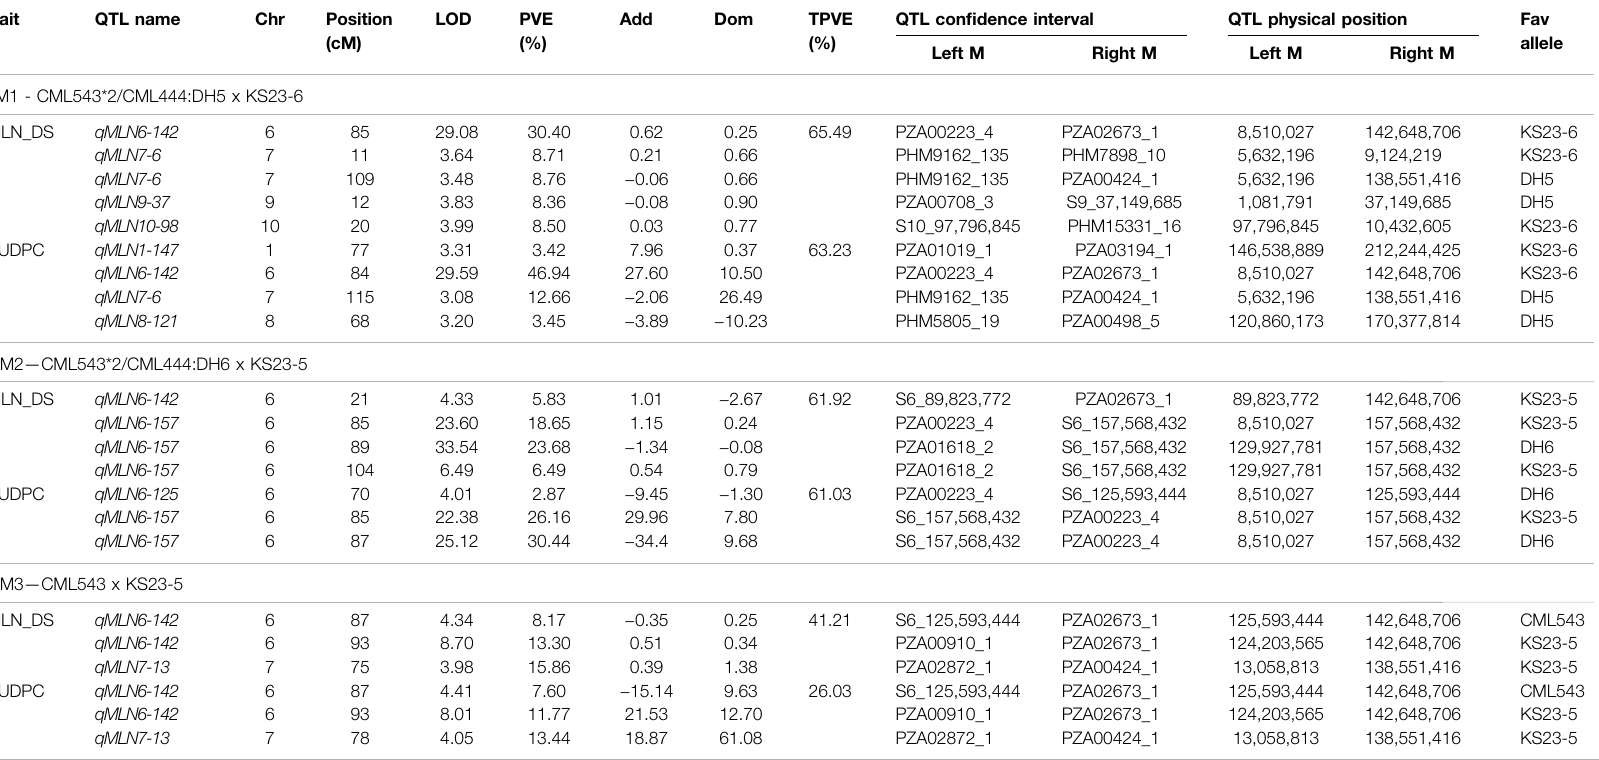
TABLE 4 | QTLs identi fi ed for MLN disease severity and AUDPC values, their physical positions, and genetic effects in three F3 QTL mapping (QM) populations.